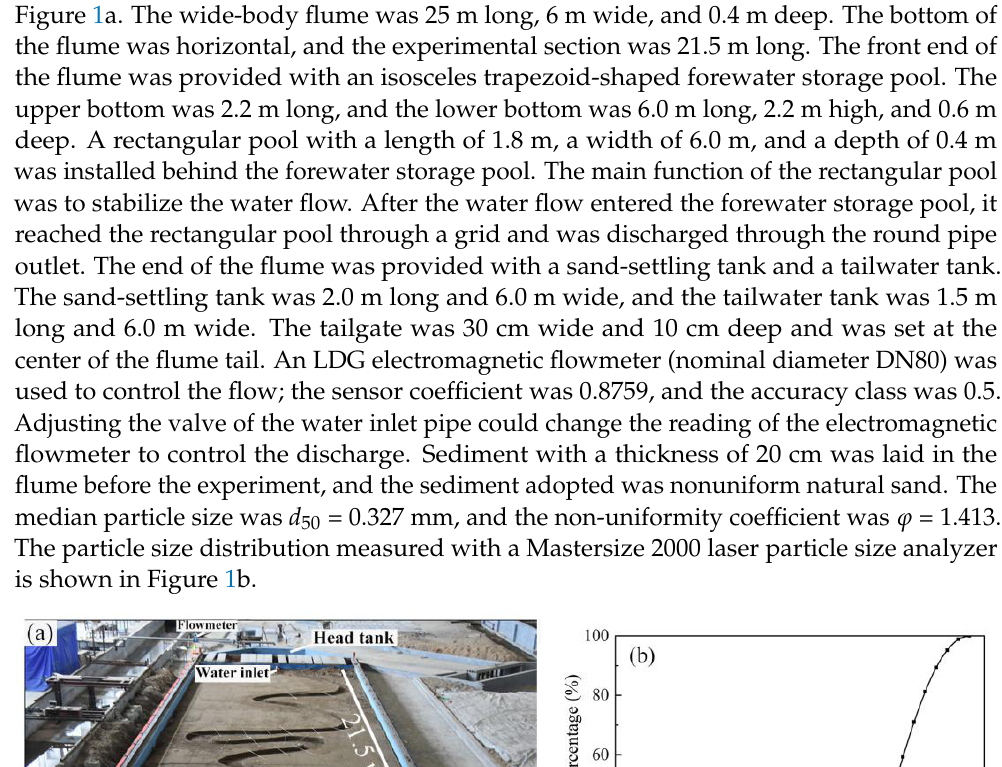
Figure 1a. The wide-body flume was 25 m long, 6 m wide, and 0.4 m deep. The bottom of the flume was horizontal, and the experimental section was 21.5 m long. The front end of upper bottom was 2.2 m long, and the lower bottom was 6.0 m long, 2.2 m high, and 0.6 m